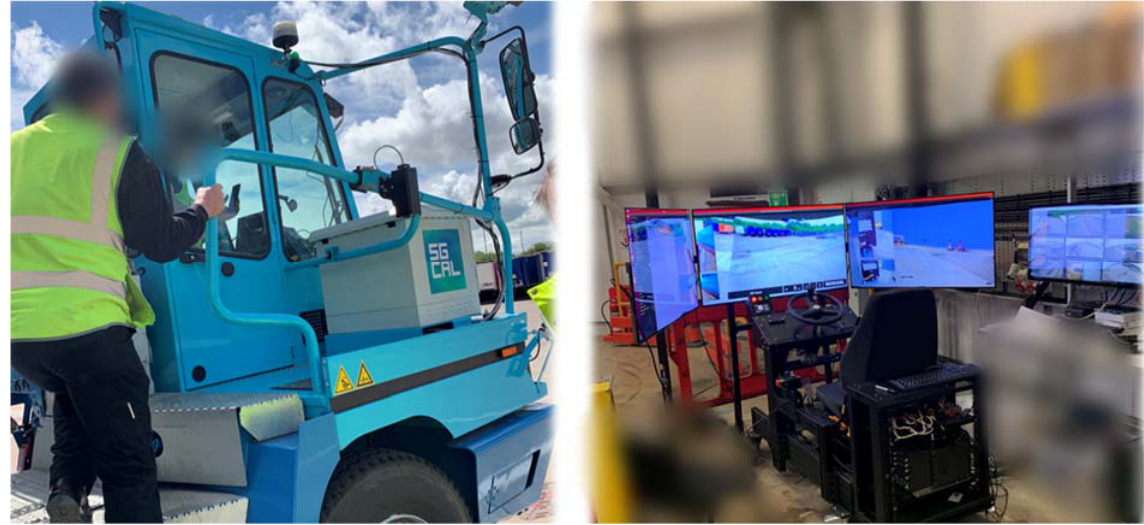
Figure 1. The Terberg autonomous heavy goods vehicle (Left) and the 5G-enabled teleoperation workstation.